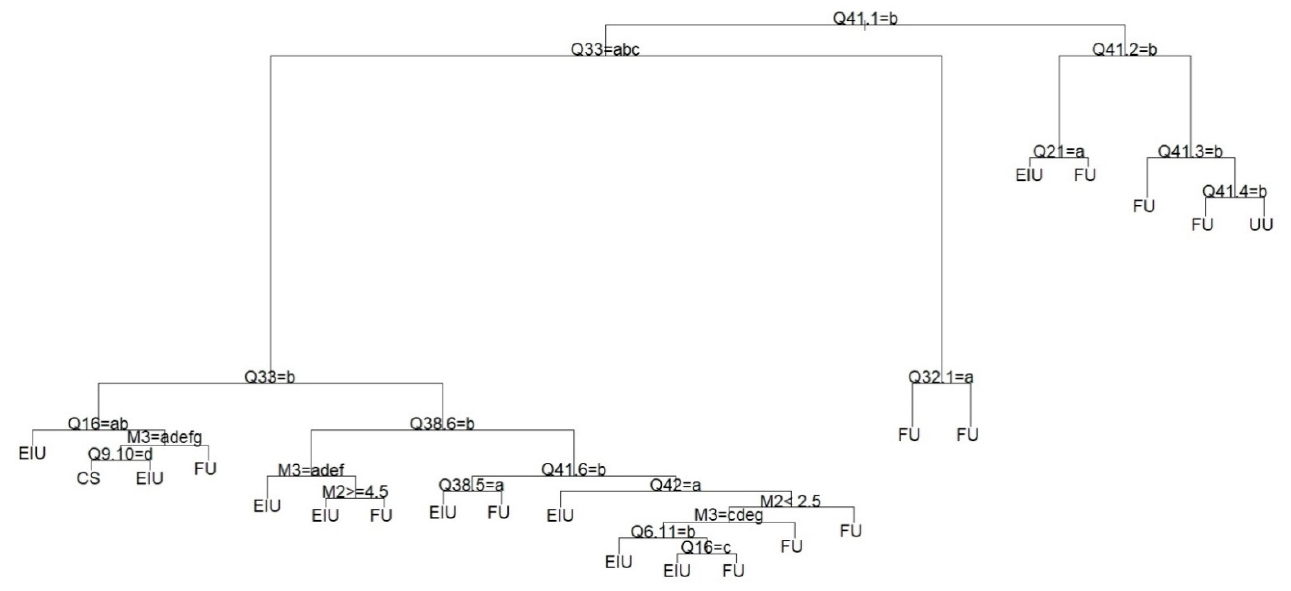
Figure 2. Classification tree characterising obtained electricity consumer segments.